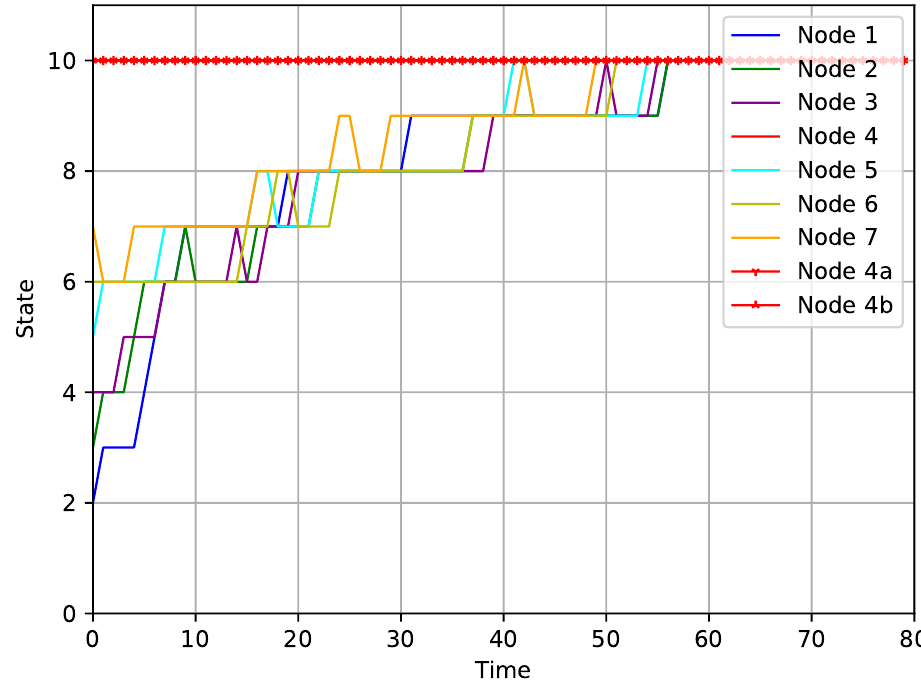
Figure 6. The MAS with QW-MSR algorithm fails to reach consensus under Sybil